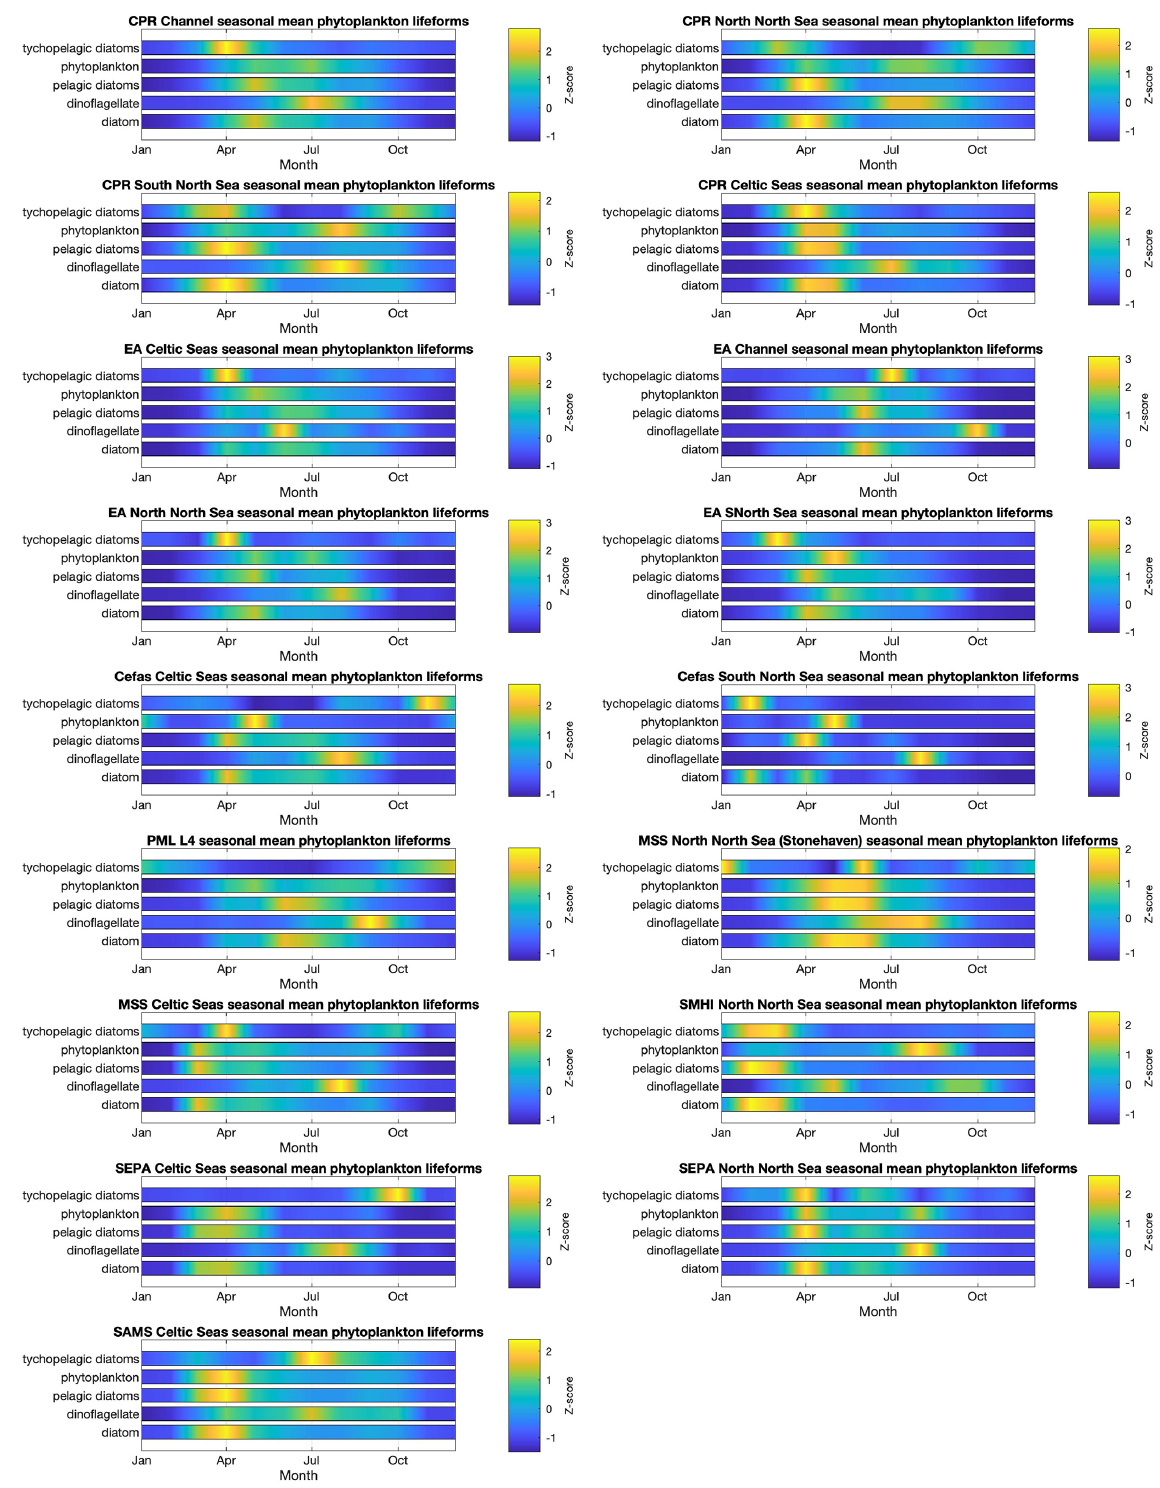
Figure 5. Phytoplankton lifeform monthly means, by data provider and region. Colour indicates lifeform abundance relative to the long-term mean of each lifeform within each region and dataset as standardized z score (Glover et al., 2005): scores of zero are equal to the long-term mean, positive scores (in green/yellow) signify values above the long-term mean, and negative scores signify values below the long-term mean (in blue). Only those lifeforms that have been assigned a confidence level of “high” are shown (see Tables 2 and 3). Regions are defined in Fig.